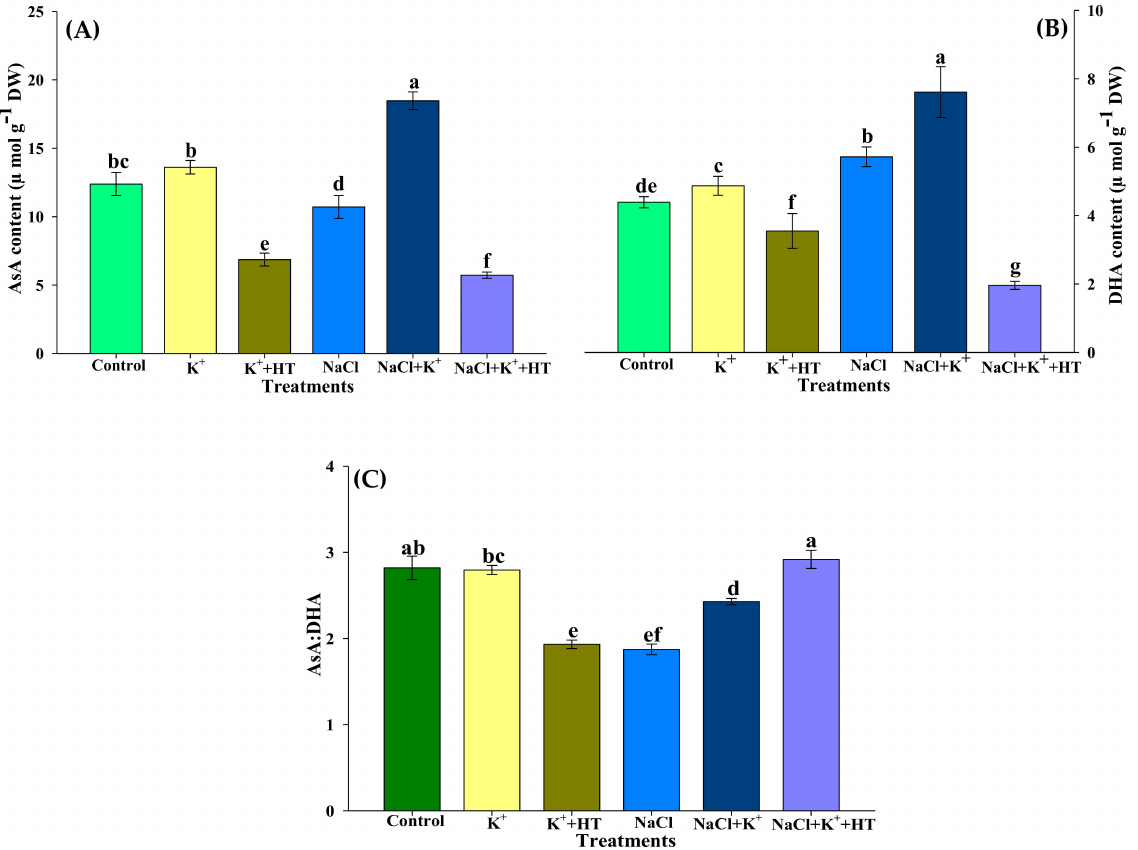
Figure 5. Effect of K + and NaCl on the non-enzymatic components of ascorbate–glutathione cycle in tomato seedling roots. ( A ) Ascorbate (AsA) content, ( B ) dehydroascorbate (DHA) content, and ( C ) AsA:DHA ratio. Double deionized water (control), 5 mM K 2 CO 3 (K + ), 100 mM NaCl (NaCl), 1 mM hypotaurine (HT: H 2 S scavenger). Values are means of five independent replicates, with bars indicating SE. Bars with different letters indicate that differences were statistically significant at p < 0.05